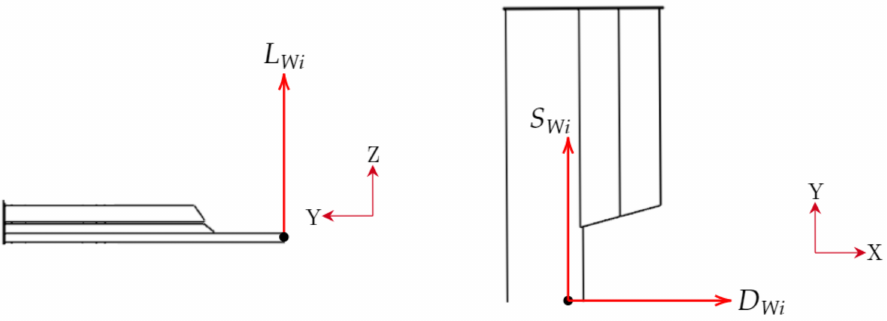
Figure 10. A schematic diagram showing the direction of the force vectors with respect to the wing under the straight-line and yaw conditions.